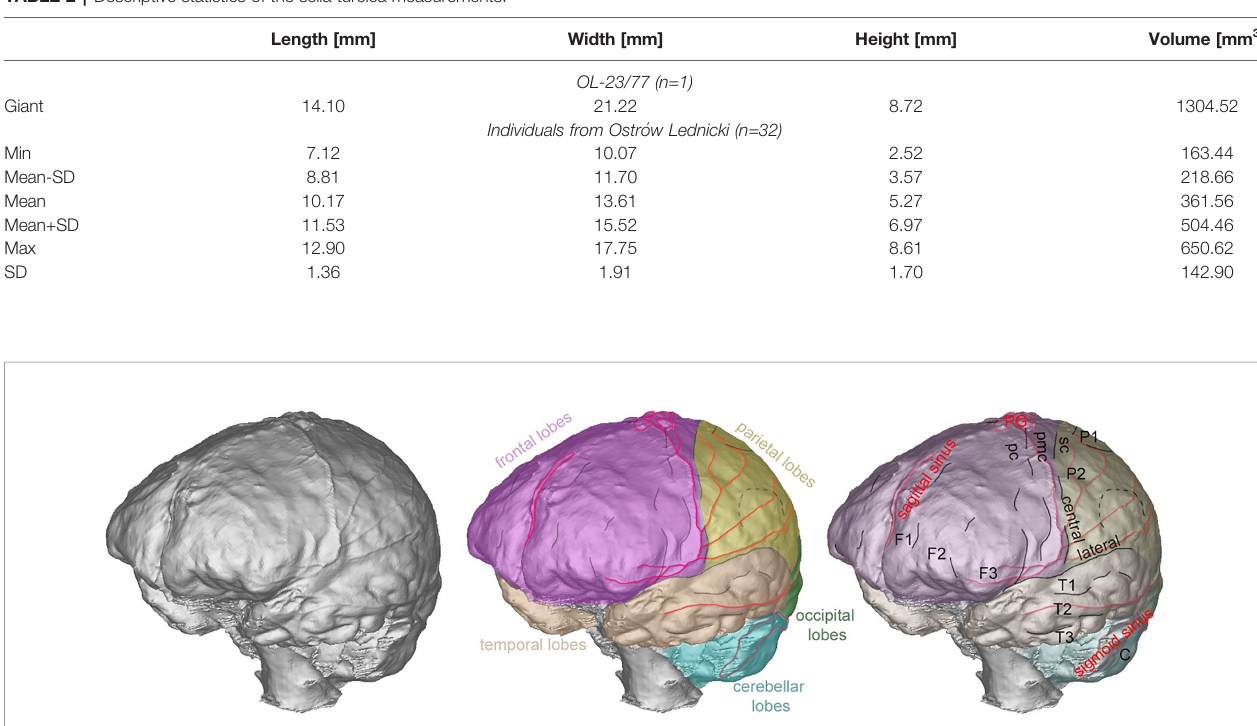
TABLE 2 | Descriptive statistics of the sella turcica